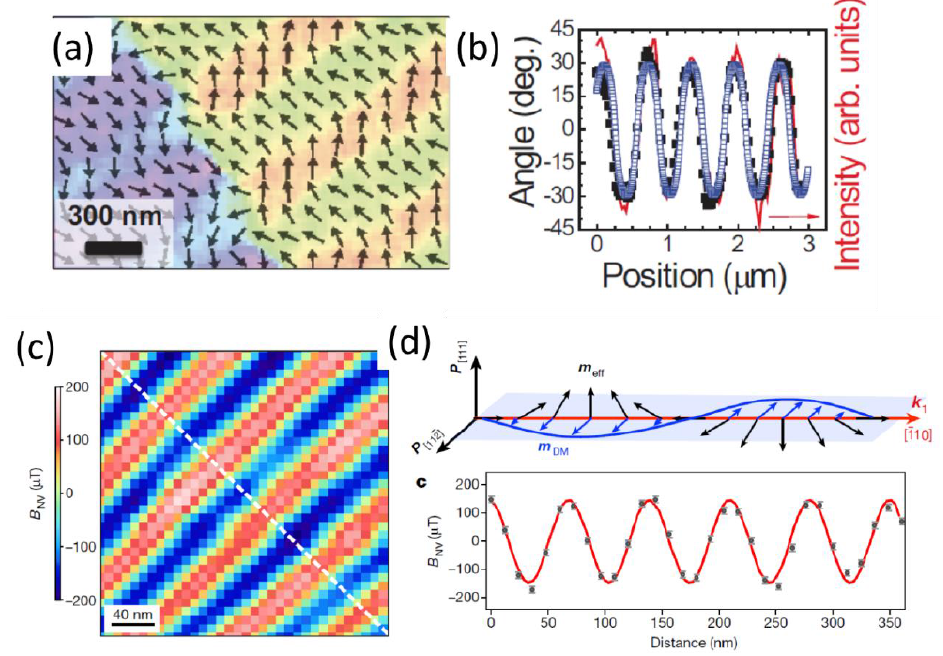
Figure 4. Imaging multiferroic domains in BFO thin films. ( a ) SEMPA showing the in-plane orientation of the ferromagnetic domains in a CoFe layer deposited on top of the multiferroic film; ( b ) Line scans from the backscattering electrons (red curve), SEMPA (filled black squares) and calculations (open blue squares) with a 7 mT effective coupling field highlight the coupling between the multiferroic and the ferromagnet. ( a , b ) Reprinted with permission from [72], Copyright the American Physical Society, 2013; ( c ) Magnetic field distribution recorded on a single ferroelectric domain showing the existence of a spin cycloid within a single ferroelectric domain; ( d ) Representation of the spin density wave (top) showing an uncompensated moment, the line scan (bottom) shows the magnetic field distribution along the cycloid propagation direction. Reprinted by permission from [78], Copyright Macmillan Publishers Ltd.: Nature,